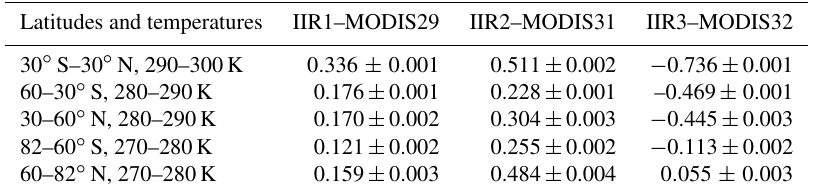
Table 6. IIR–MODIS brightness temperature differences in Kelvin at the beginning of the CALIPSO mission and associated uncertainty at the warmest temperature range in each latitude